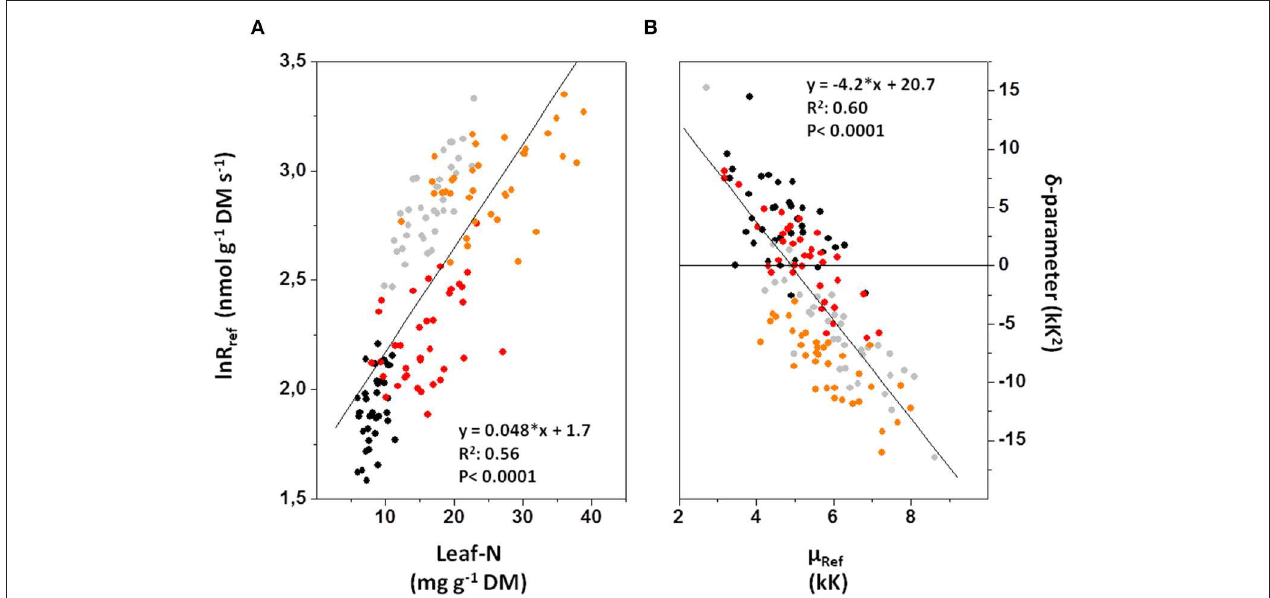
FIGURE 7 | Relation between parameters of respiratory oxygen reduction, as affected by nitrogen status of Eucalyptus leaves. (A) Correlation between respiratory capacity (i.e., lnR ref ) and foliar N-contents. (B) Correlation between the temperature coefficient of O 2 -reduction at 15 ◦ C reference temperature [equivalent to overall activation energy at reference temperature, since µ Ref = E o (Ref.)/ R ], and the dynamic change of activation energy with measurement temperature ( δ -parameter). Black symbols : Eucalyptus grandis (mature leaves); gray: E. grandis (young leaves); red: E. regnans (mature); orange: E. regnans (young). In order to explore sources of residual variation, data were further analyzed via ANCOVA ( Table 4 and Figures 8 , 9 ) and via Principal Component Analysis ( Table 5